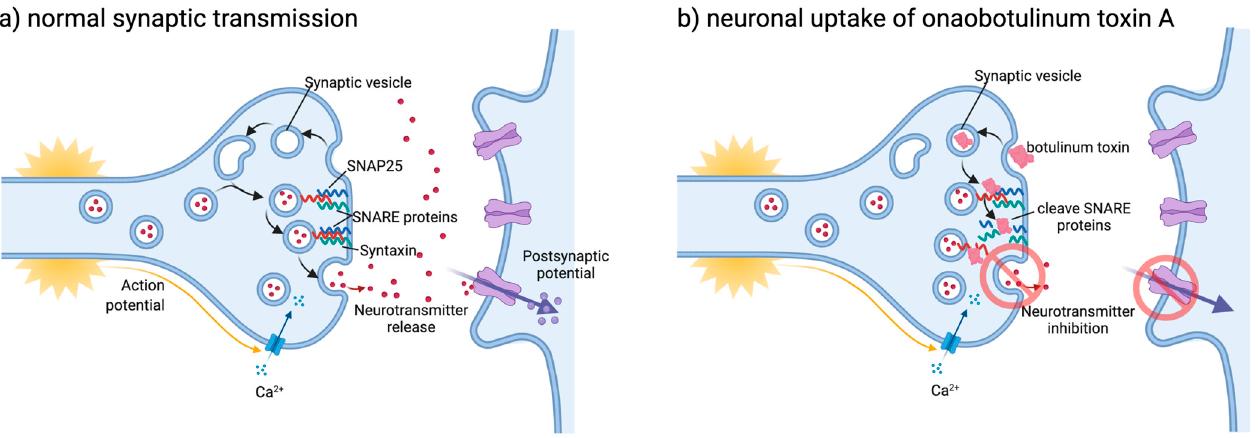
Figure 2. Mechanism of action of botulinum toxin [12]. ( a ) Normal synaptic transmission; arriving active channel opens voltage-gated calcium channels, allowing influx of calcium. Calcium allows synaptic vesicle docking via SNARE proteins, neurotransmitter release, and activation of post-synaptic potential. ( b ) Neuronal uptake of onabotulinumtoxinA, internalisa- tion of botulinum toxin via synaptic vesicle, and cleavage of SNAP-25 protein causing inhibition of neurotransmitter release.